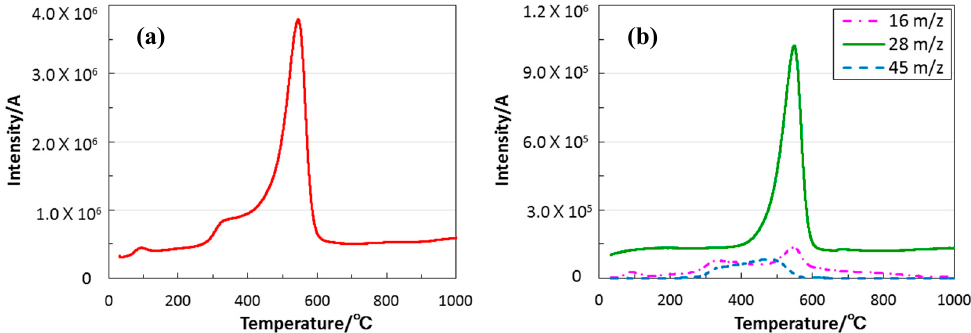
Figure 5. The relationships of heating temperature and evolution of gaseous species; ( a ) total ion current chromatogram (TICC); and ( b ) Constituents of evolved gaseous species.